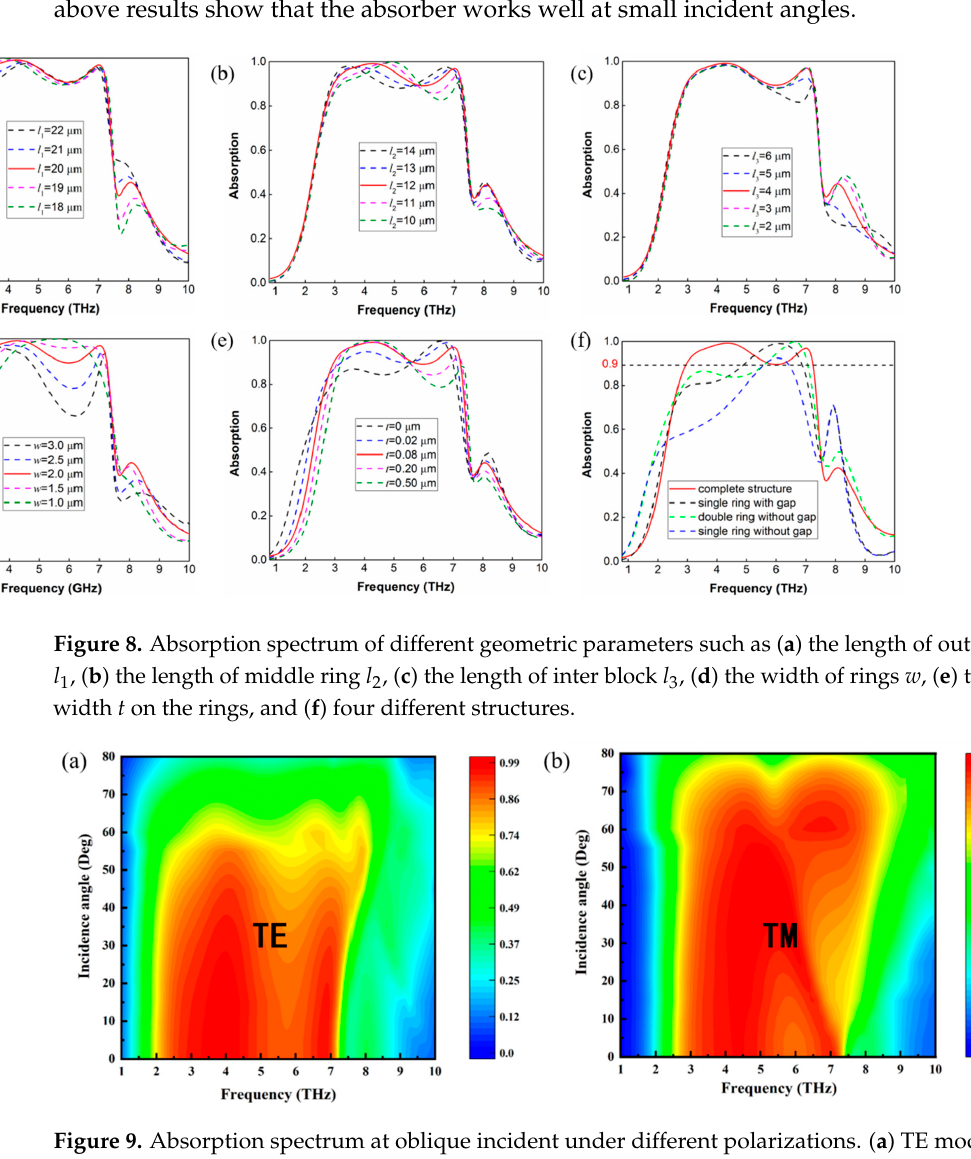
Figure 9. Absorption spectrum at oblique incident under different polarizations. ( a ) TE mode and ( b ) TM mode.